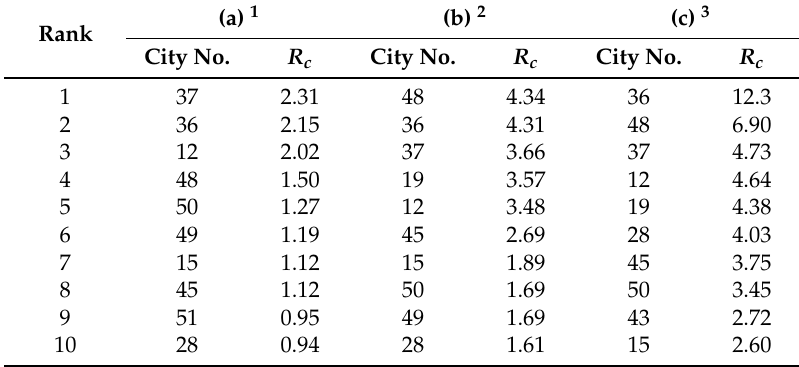
Table 4. The ranking table of potential risk (R c ) of cities in the Nakdong River Basin.